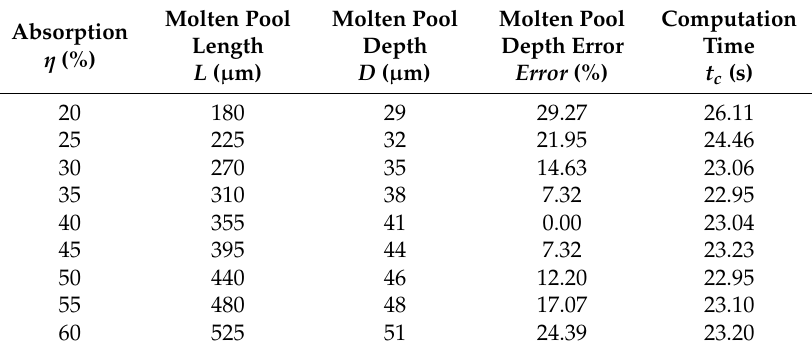
Figure 3. Inverse determination of laser absorption based on melt depth prediction using the trial-and-error method under test 6 process condition. Table 3. Inverse determination of laser power absorption in this study.